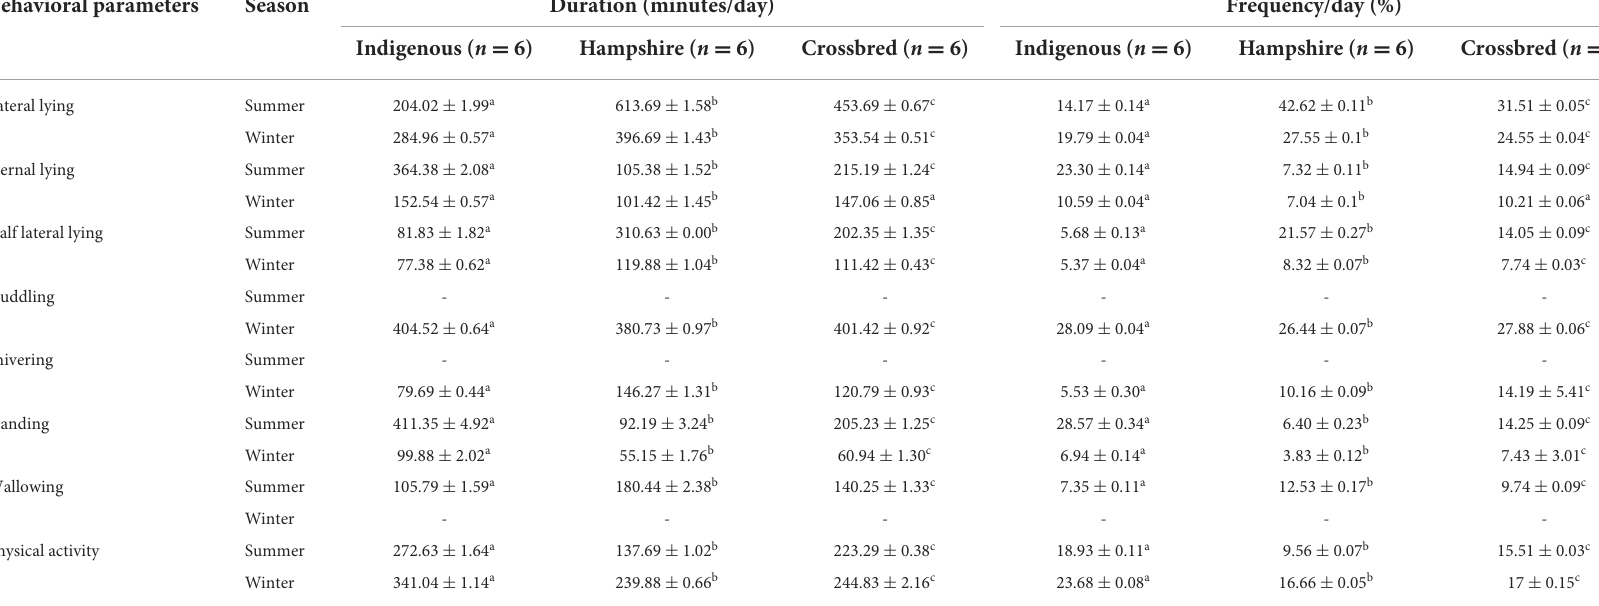
TABLE 3 Means ± SE for behavioral parameters of indigenous, Hampshire, and crossbred pigs in response to heat and cold stress observed under a CCTV video camera during the experimental